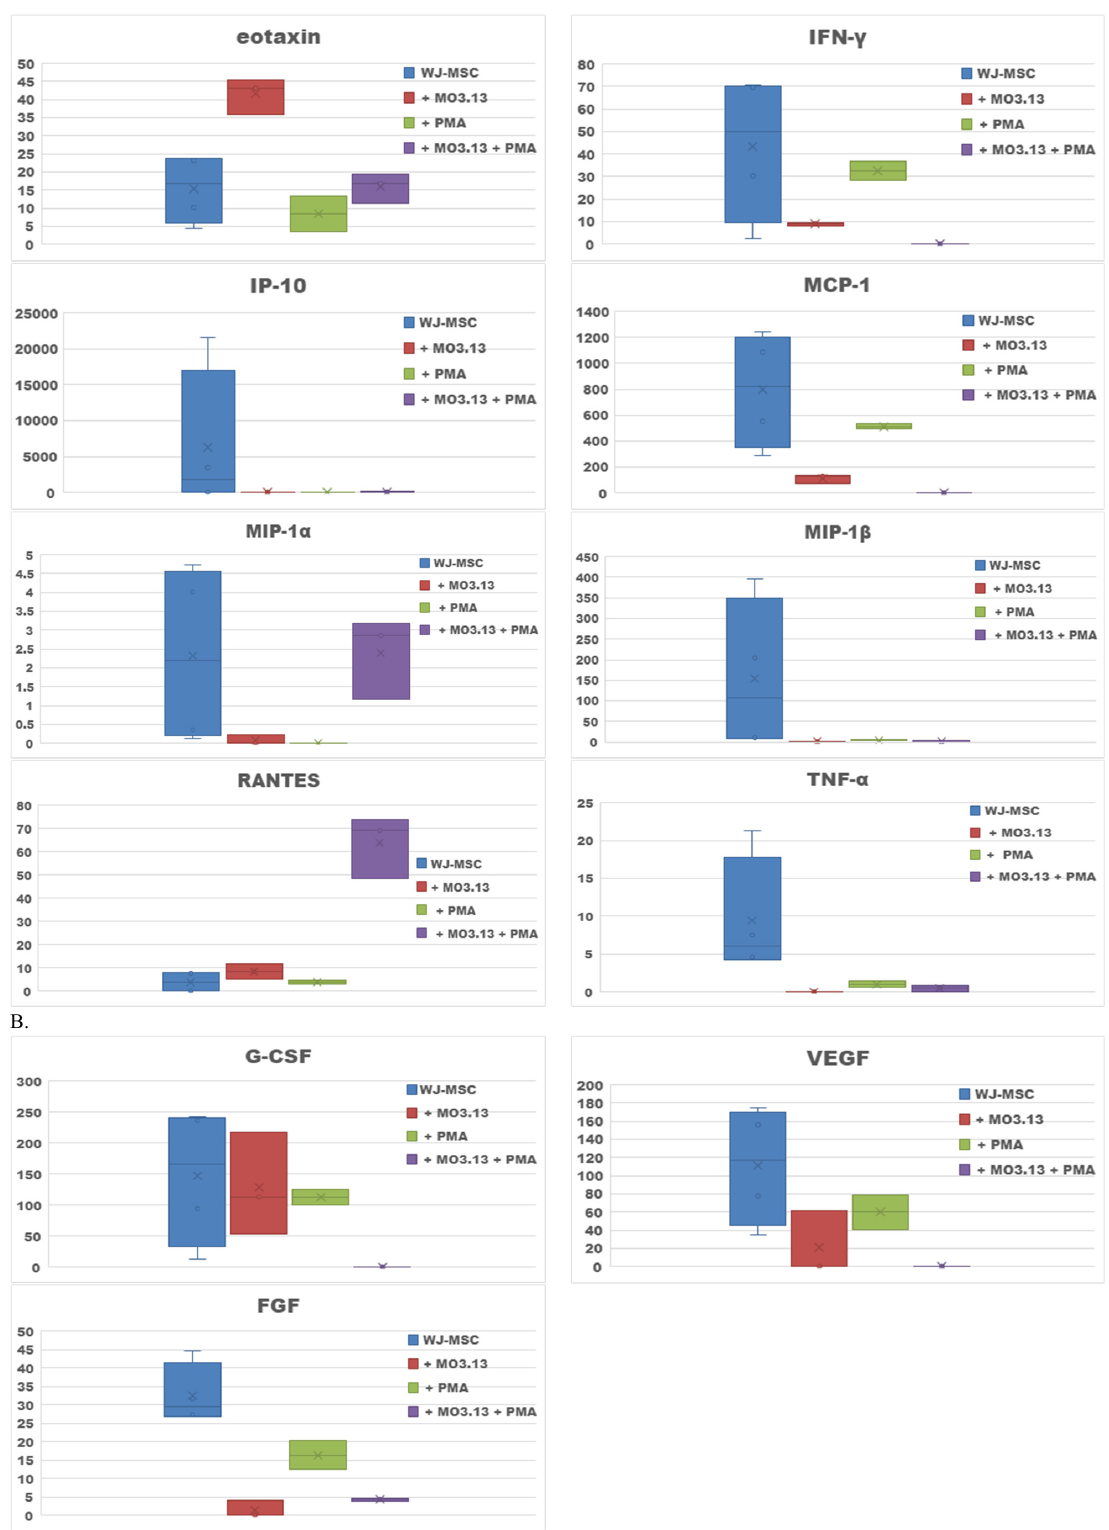
Figure 3. The average concentrations of cytokines and chemokines ( A ) and growth factors ( B ) secreted in co-cultures of WJ-MSCs and MO3.13 cell line (pure and with addition of PMA) compared to the WJ-MSCs culture. Data are given in pg/mL as means ± SD from 4 samples for WJ-MSCs, 3 samples for WJ-MSCs + MO3.13, 2 samples for WJ-MSCs with PMA, 3 samples for WJ-MSCs + MO3.13 with